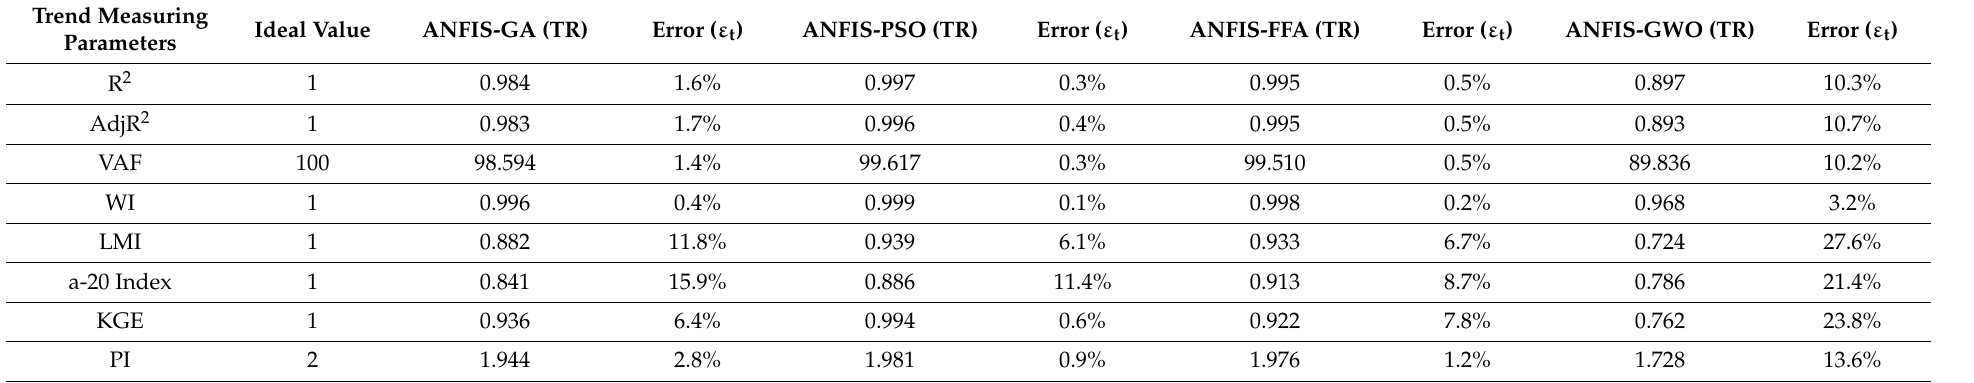
Table 8. Computed error for trend measuring parameters (training dataset).